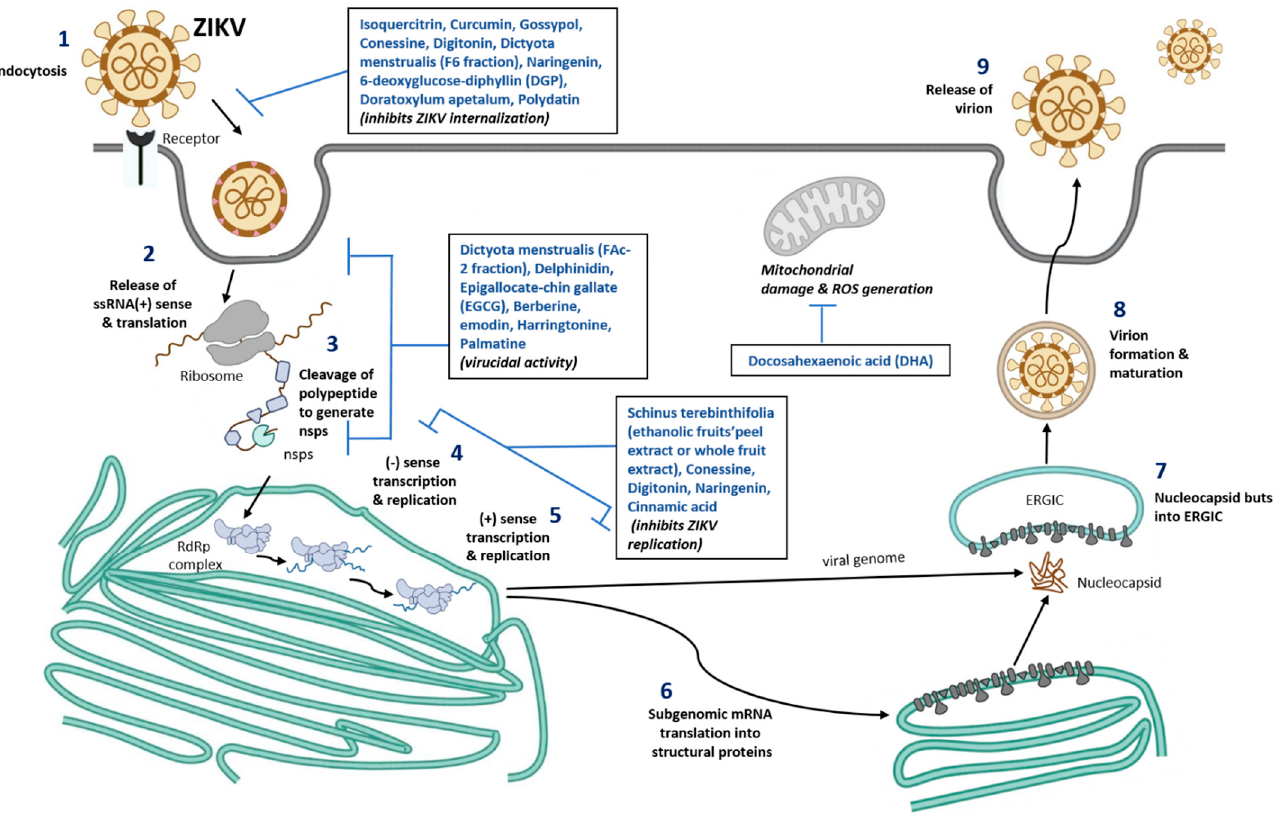
Figure 1. Schematic representation of nutraceuticals role in blocking ZIKV replication. Number 1–9 represent different stages of ZIKV infection, viral assembly, new viral formation, and release of mature virus from the infected cells. Nutrients compound identified that are known to inhibit various stages of viral infection are listed in the box inserts. ssRNA, single stranded ribonucleic acid; ERGIC, ER-Golgi intermediate compartment; RdRp, RNA dependent RNA polymerase; ROS, Reactive oxygen species; nsps, non-structural proteins of Zika virus. Table 2. List of novel nutrient molecules and mechanism of protection against ZIKV infection.